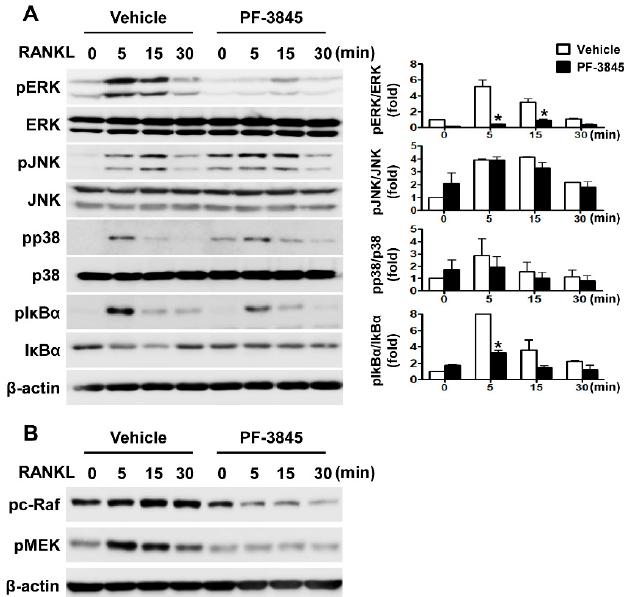
Figure 4. The effect of PF-3845 on RANKL-induced signaling in BMMs. ( A , B ) BMMs incubated in a serum-free medium for 5 h were treated with the vehicle or PF-3845 (10 μ M). After incubation for 1 h, the cells were treated with RANKL (50 ng/mL) for the indicated time periods. Cell lysates were subjected to immunoblot analysis. ( A ) The expression of phosphorylated-ERK, -JNK, -p38, and -I κ B α was assessed. The total ERK, JNK, p38, I κ B α , and β -actin were used as the loading controls. ( B ) Phosphorylation of c-RAF and MEK were determined by Western blot analysis. β -actin was used as the loading control. * p < 0.05 (two-tailed Student’s t